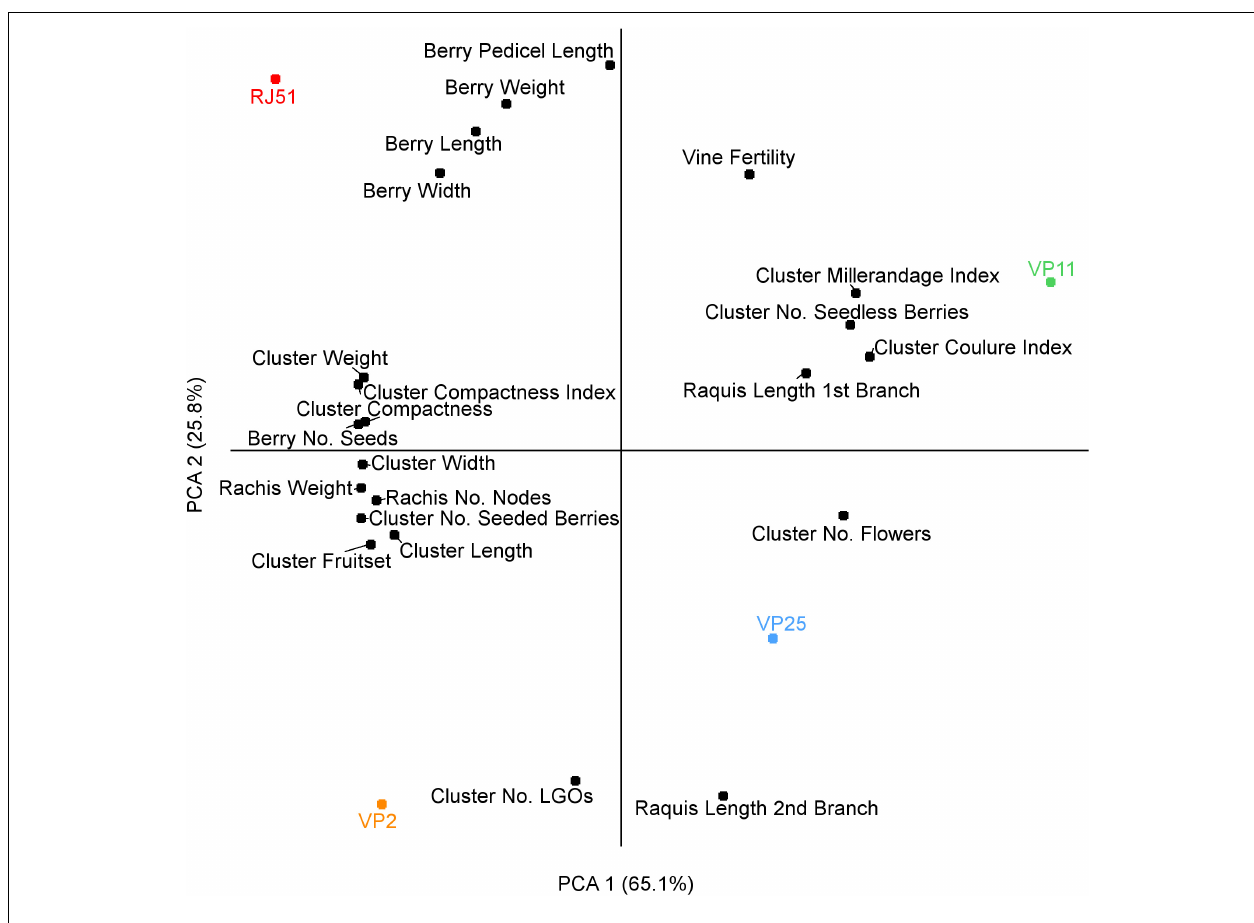
FIGURE 1 | PCA analysis for the phenotype